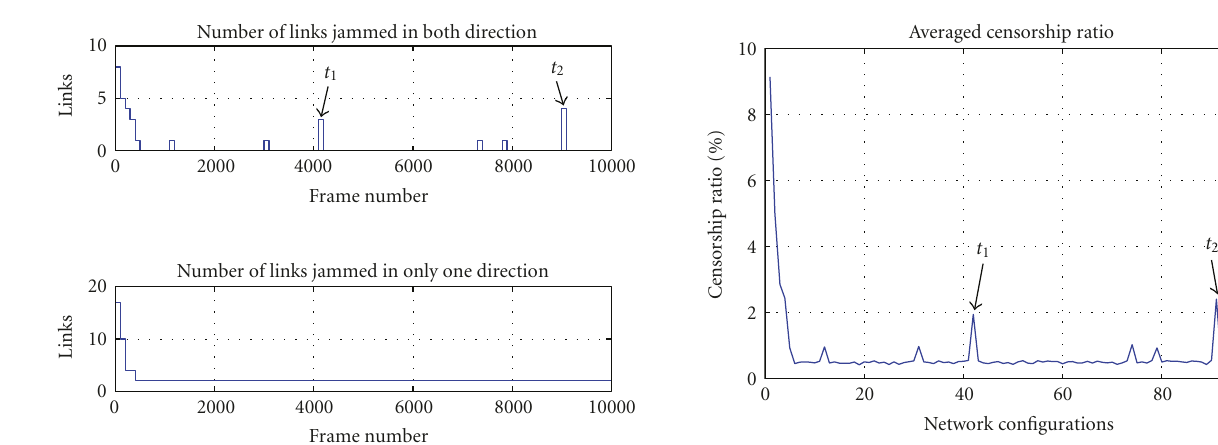
Figure 16: Number of links jammed in 2 (1) direction used for communication.